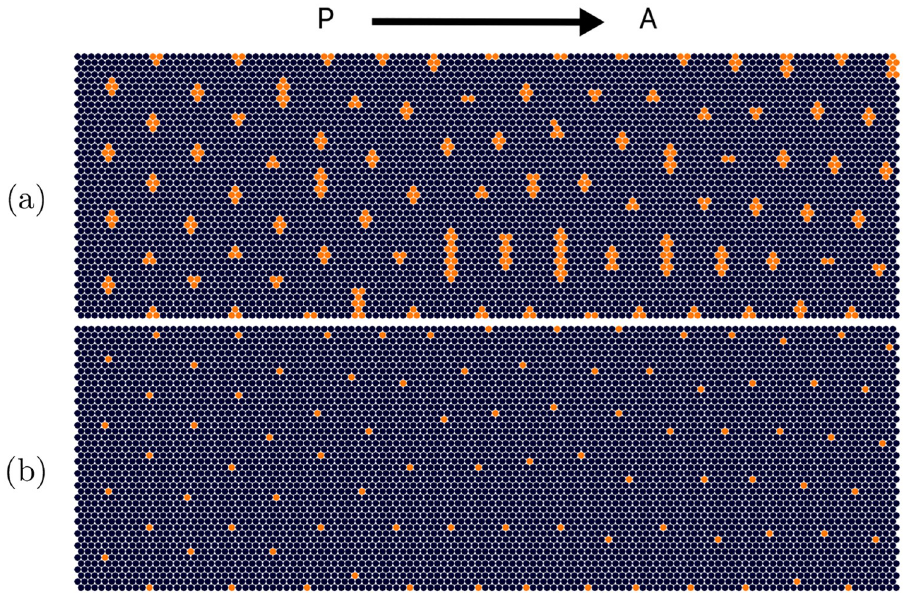
Fig 5. Visualization of the cluster refinement step. The code takes the ato expressing cell clusters, as shown in (a), as an input and determines the single R8 cell that will become the center of the future ommatidium, as shown in (b). This example is shown for a noise level of σ / μ = 40%, applied to the diffusivity of the morphogens u and s .